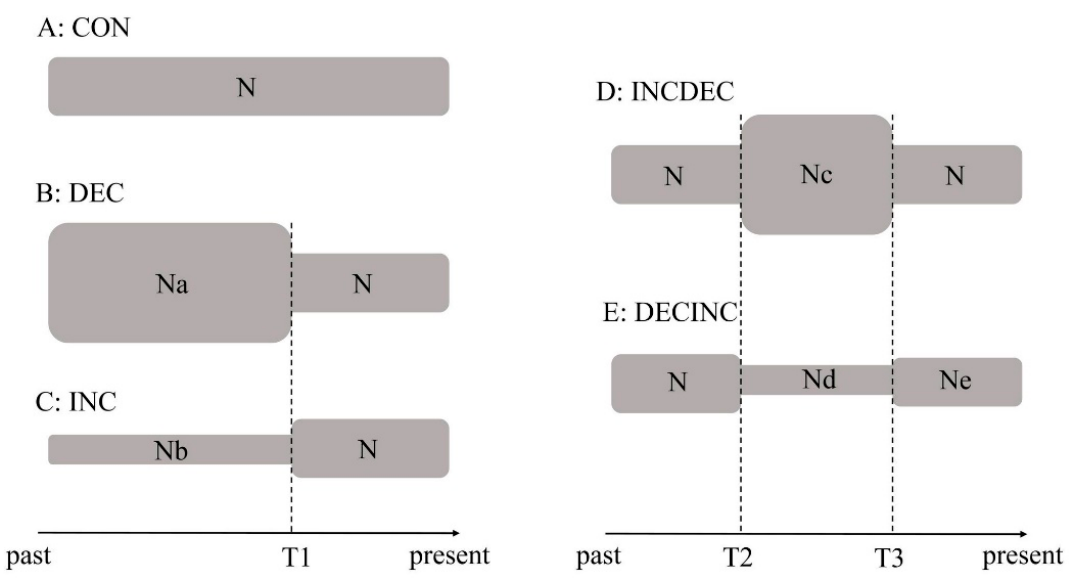
Figure 2. Schematic representation of five demographic scenarios for Macrobrachium japonicum tested by approximate Bayesian computation ( A – E ). Time and effective population size are not to